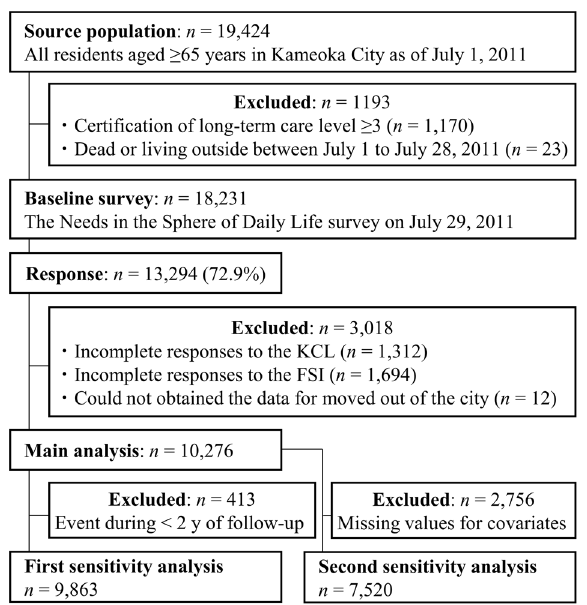
Figure 1. Participant flow diagram for the analysis of frailty status and mortality in Kyoto-Kameoka study. FSI, frailty screening index; KCL, Kihon